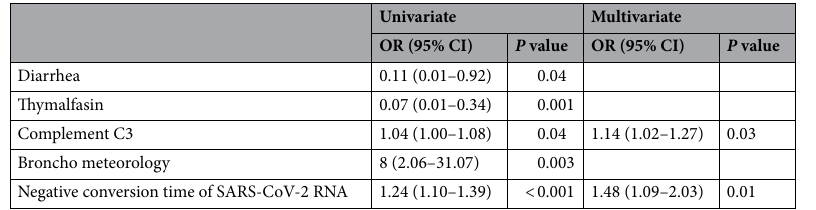
Table 4. Univariate and multivariate logistic regression analysis of factors associated with delayed discharge of patients with COVID-19. CI confidence interval, OR odds